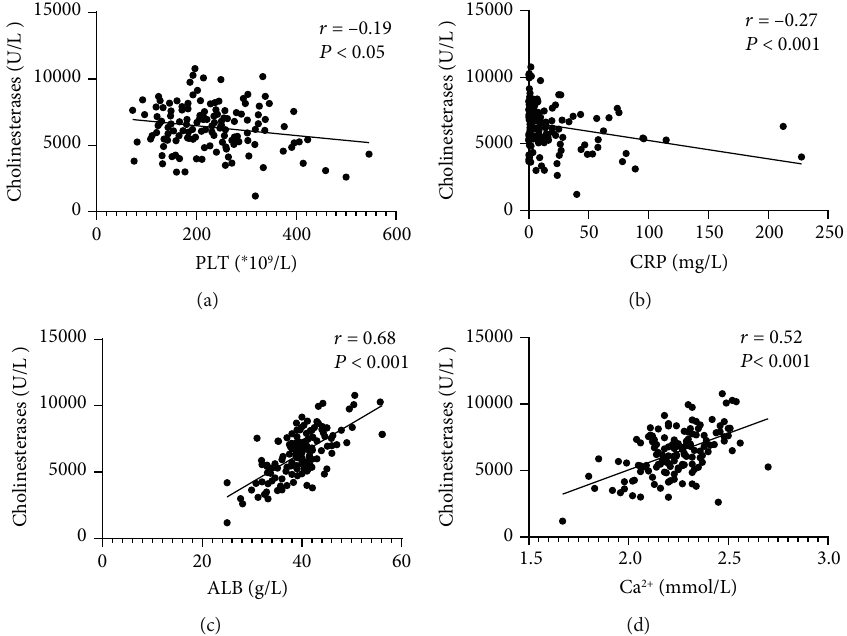
Figure 4: The correlation between serum ChE levels and (a) PLT, (b) CRP, (c) ALB, and (d) Ca 2+ level in UC patients by using a scatter